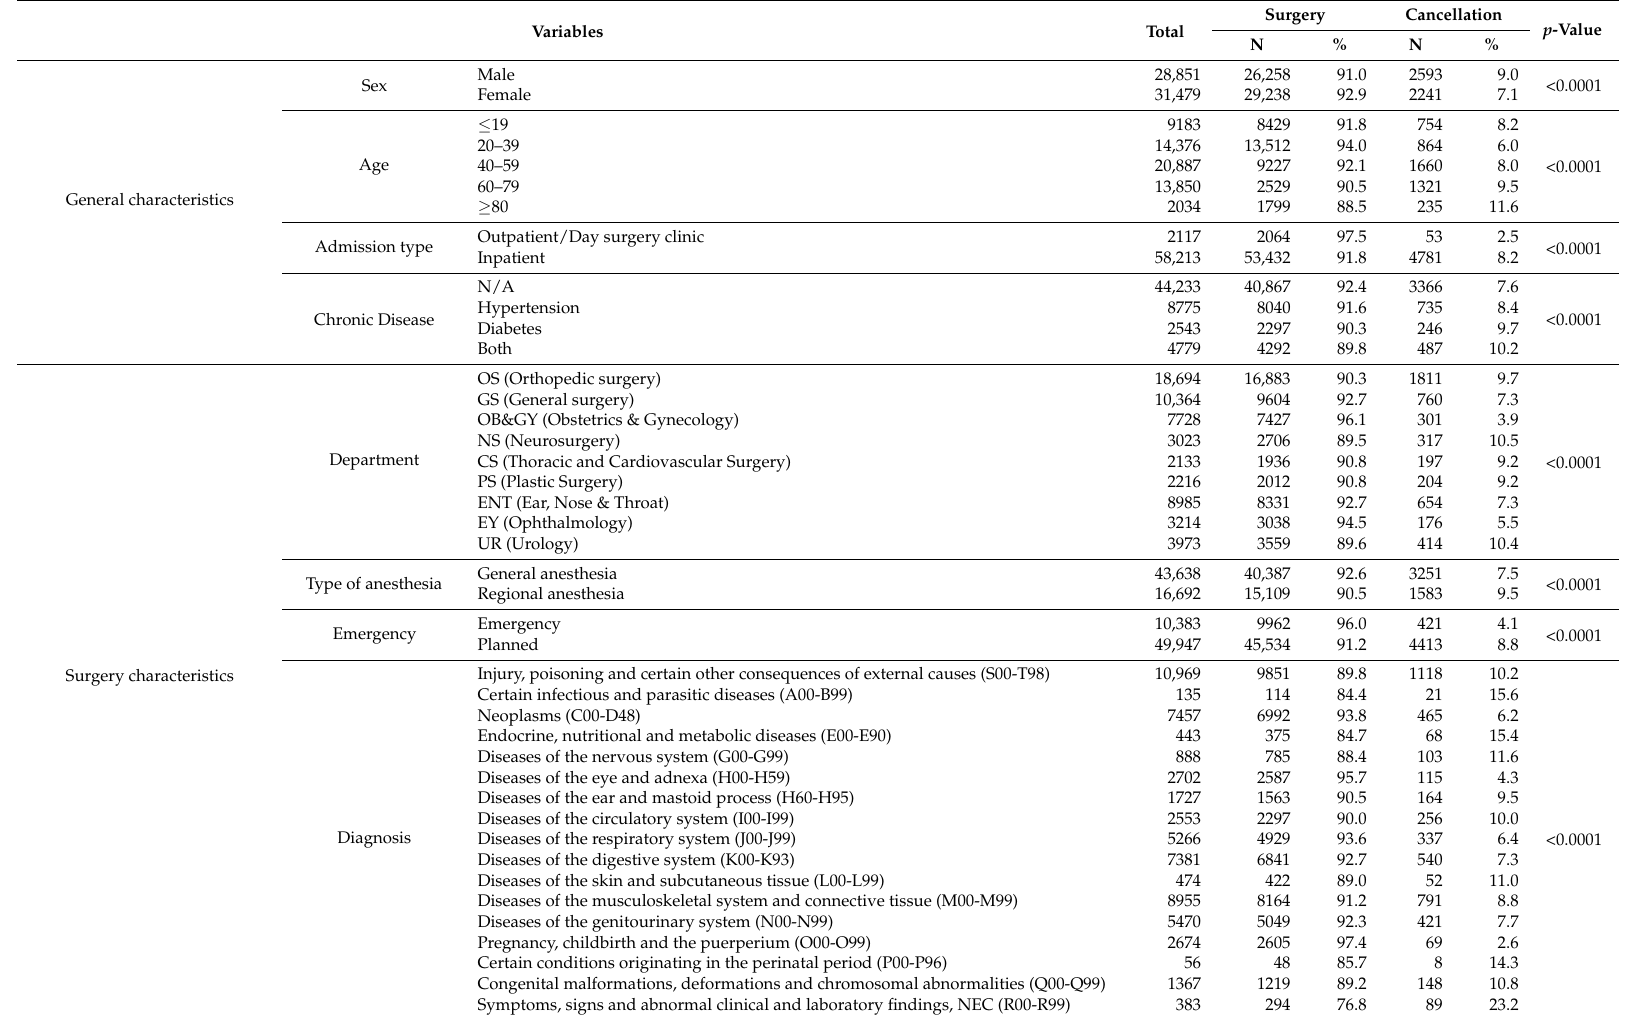
Table 1. General, Surgery and operation schedule characteristics of study